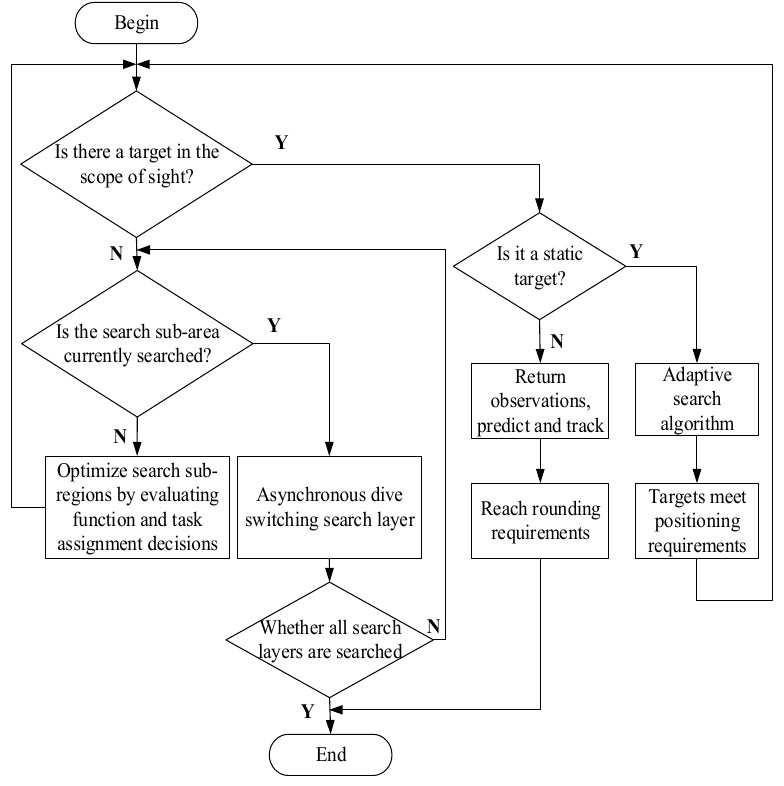
Figure 3. Adaptive predictive search algorithm flow chart.